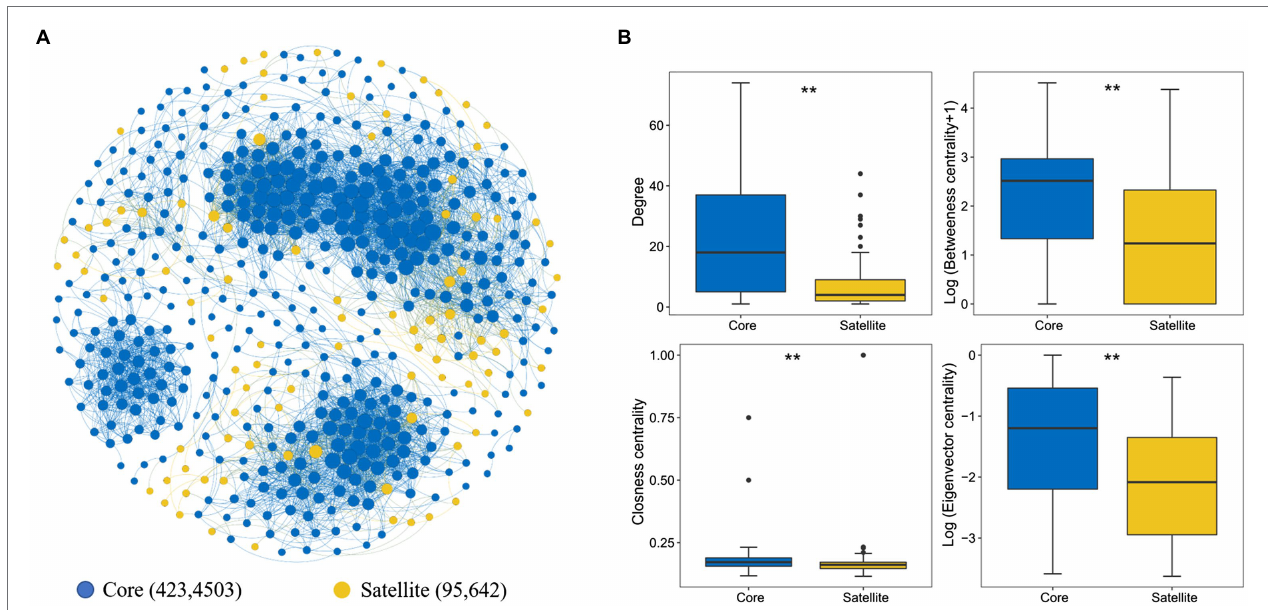
FIGURE 6 | Properties of the correlation-based network among the core and satellite sub-communities. (A) Network of inter-taxon associations within and between core and satellite sub-communities. A connection stands for a strong (Spearman’s ρ > 0.6 or ρ < − 0.6) and significant ( p < 0.01) correlation. The size of each node is proportional to the degree of the OTU. Numbers represent the nodes and edges of the core and satellite sub-communities. (B) . Comparison of node-level topological features between two different sub-communities. “**” indicates significant differences ( p < 0.05), determined by the Kruskal-Wallis